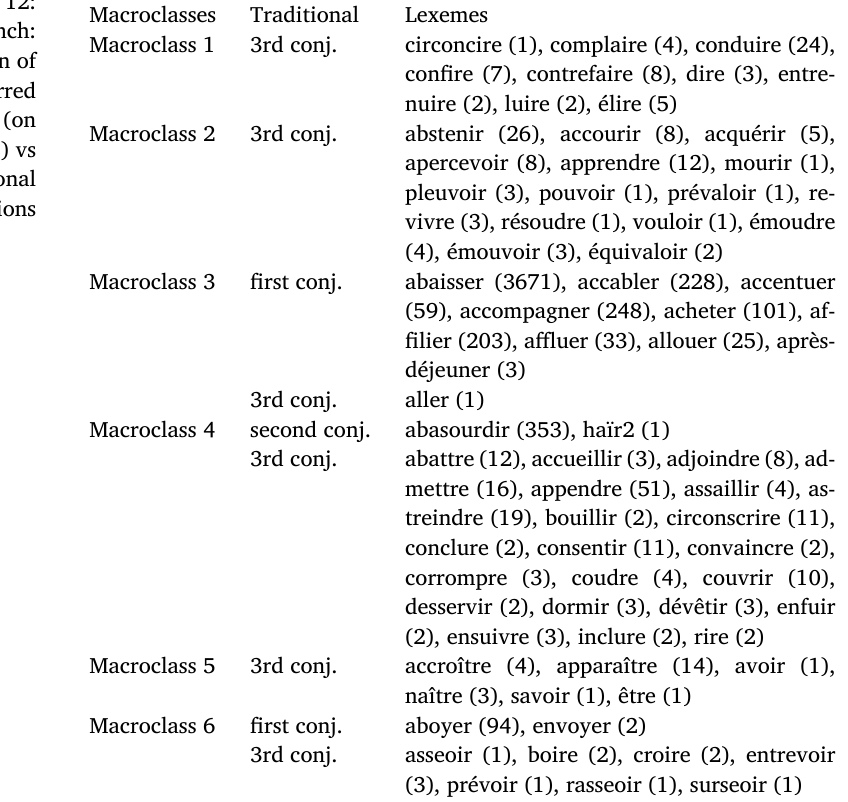
Table 12: French: Comparison of inferred macroclasses (on local patterns) vs